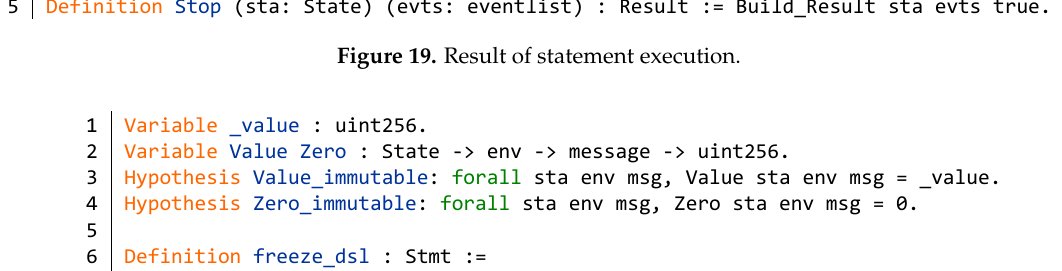
Figure 19. Result of statement execution.